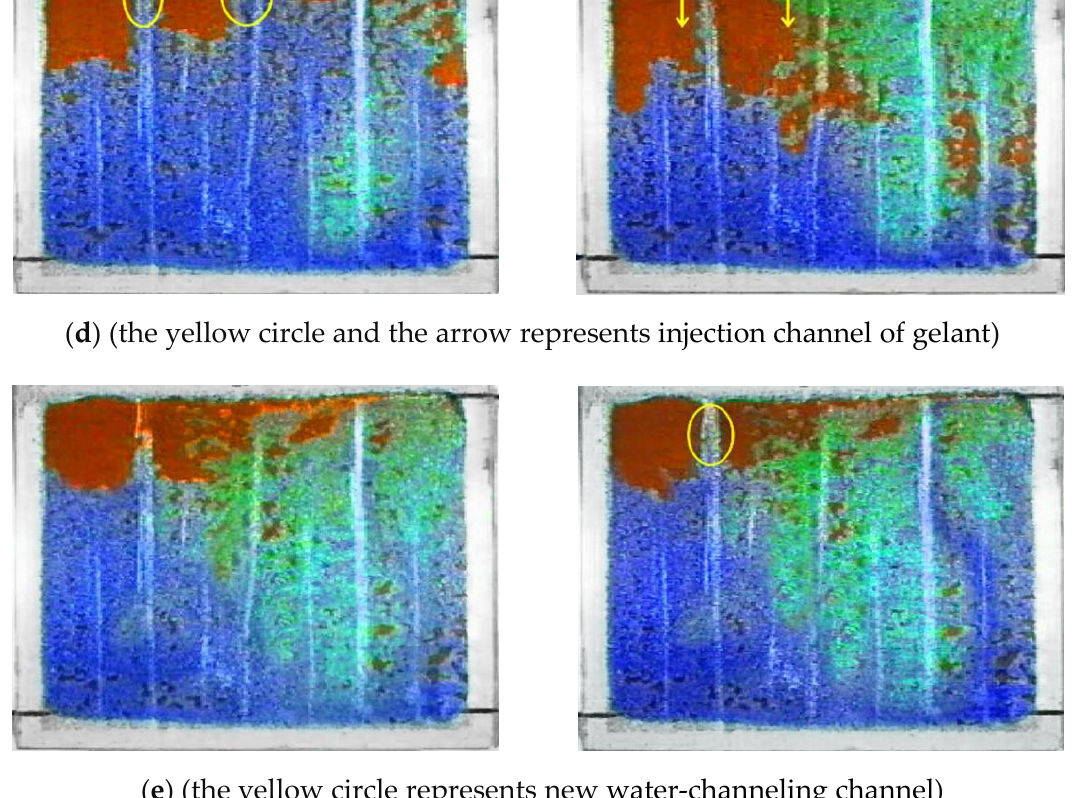
( e ) (the yellow circle represents new water-channeling channel) Figure 11. Visual physical simulation experiments: ( a ) horizontal well with bottom water; ( b ) bottom water coning; ( c ) injecting high-density brine and transition-density brine and injecting the gelants; ( d ) injecting displacement fluid; ( e ) resumption of production.